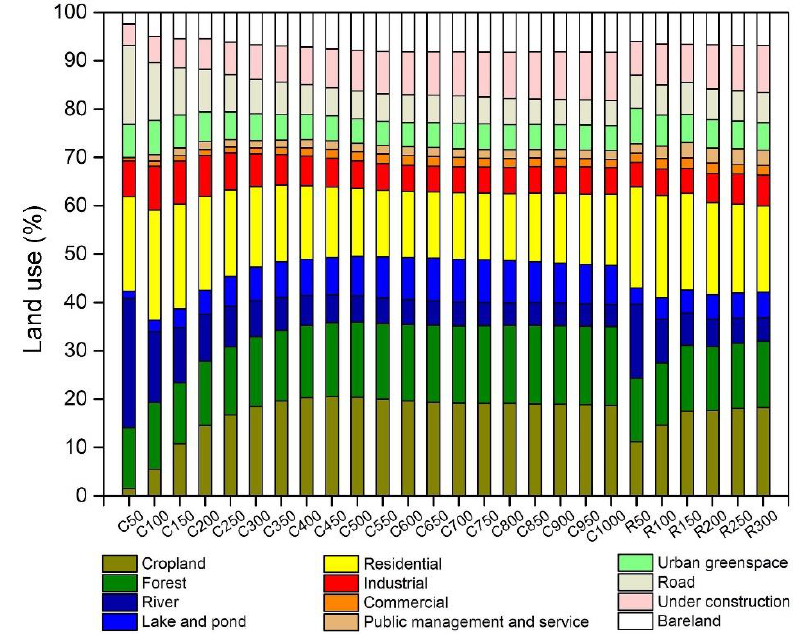
Figure 5. Proportions of each land use at different buffer scales. The labels at the x-axis indicate different buffer zones for the circular and riparian buffer scales, respectively. The initial character “C” or “R” represents the circular or riparian buffer types, and the numerical values after that character means the corresponding buffer radius. For example, “C50” means a circular buffer with a radius of 50 m around a sampling point. Hereinafter, the same.